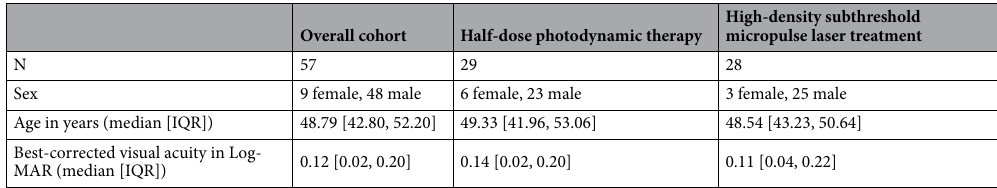
Table 1. Baseline characteristics of chronic central serous chorioretinopathy patients included in the current study. IQR interquartile range, LogMAR logarithm of the minimum angle of